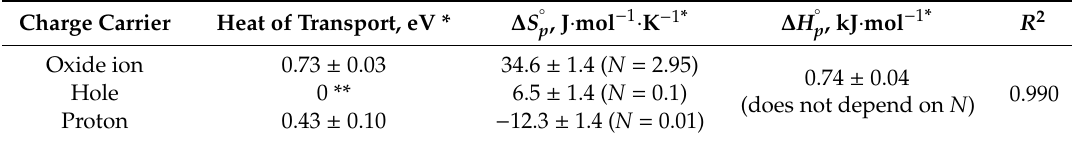
Table 2. Fitted parameters of Equation